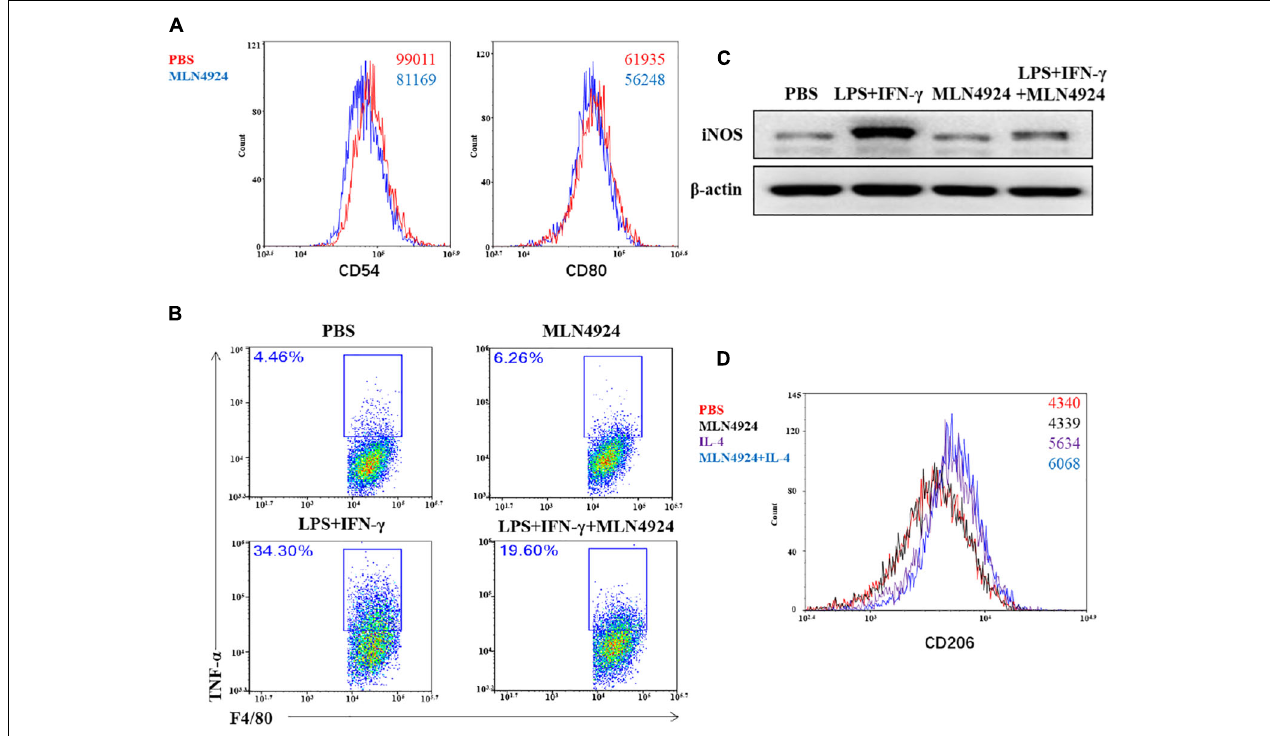
FIGURE 5 | Neddylation regulates the polarization of macrophages. (A,B,D) Flow cytometric analysis of MLN4924-treated BMDMs, LPS and IFN- γ -induced Ml macrophages, and IL-4-induced M2 macrophages. BMDMs were isolated from 8-week old wild type mouse and stimulated with L929 supernatant for 7 days, and then treated with MLN4924 (0.5 µ M for 24 h). (C) The expression of iNOS in BMDMs after stimulation by LPS and IFN- γ for 24 h.